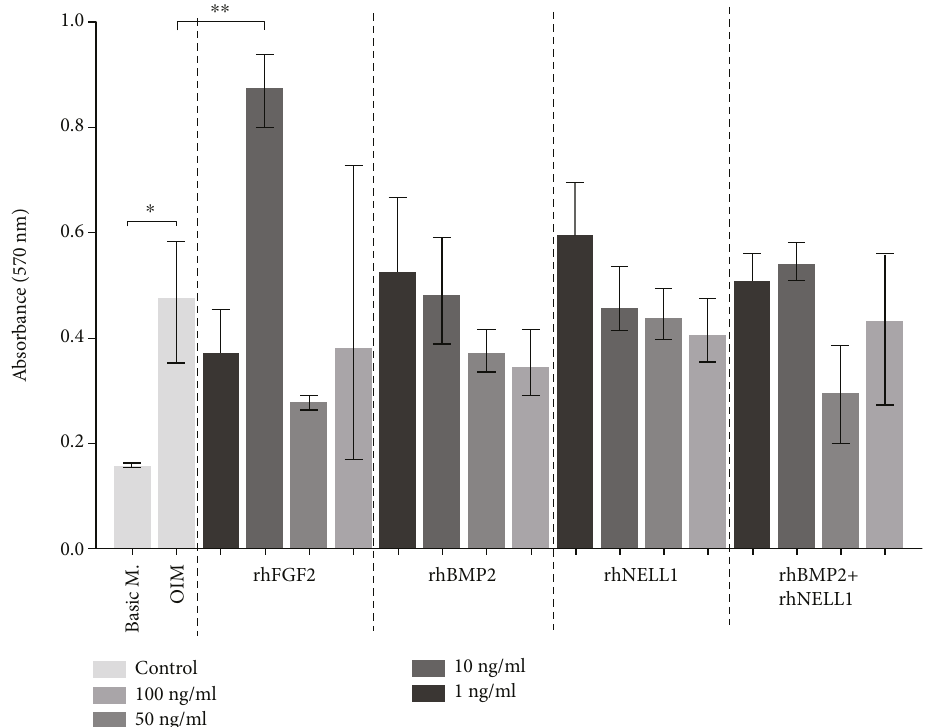
Figure 4: Quanti fi cation of the Alizarin red staining was made by hexadecylpyridinium chloride monohydrate (CC) after visualization. All wells were subtracted background from an average of 3 wells of 100 μ l CC. Unpaired ANOVA was made on the mean values with SD of all wells and compared with Basic M. (basic medium) and OIM alone by Welch t -test. ∗ indicates statistical signi fi cance ( p < 0 05 ) between basic medium and OIM group. ∗∗ indicates statistical signi fi cance ( p < 0 05 ) to OIM in a nonpaired t -test between the two control